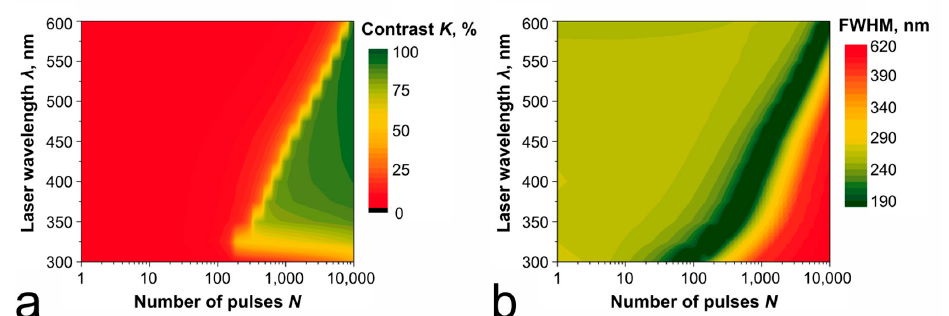
Figure 11. Estimated contrast ( a ) and respective FWHM ( b ) of the elements recorded under various conditions on a 60 nm-thick Ti film by the radiation of different wavelengths with fluence ε 0 = 0.2 J/cm 2 . Data for contrast are shown for a wavelength of the recording laser radiation.